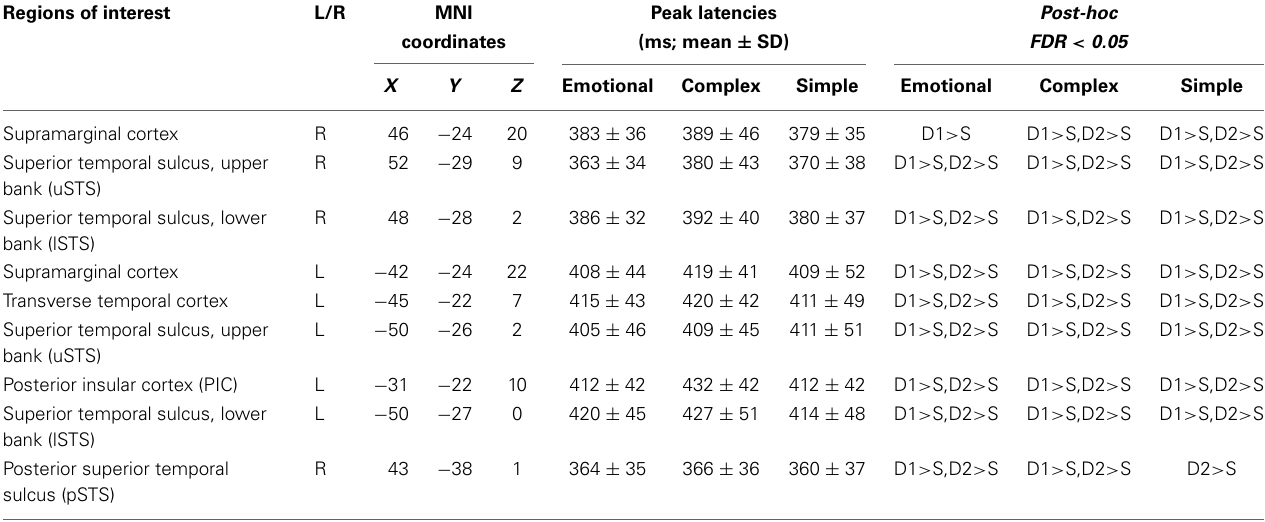
Table 3 | P3am-related cortical